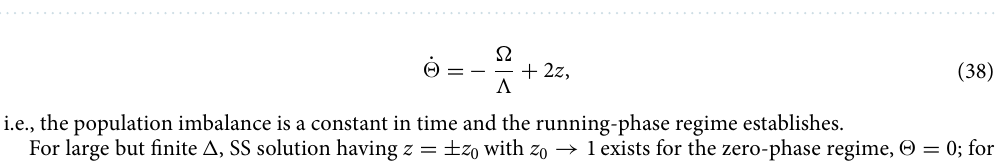
Figure 5. Phase plane z 10 ( f ) (cid:31) =